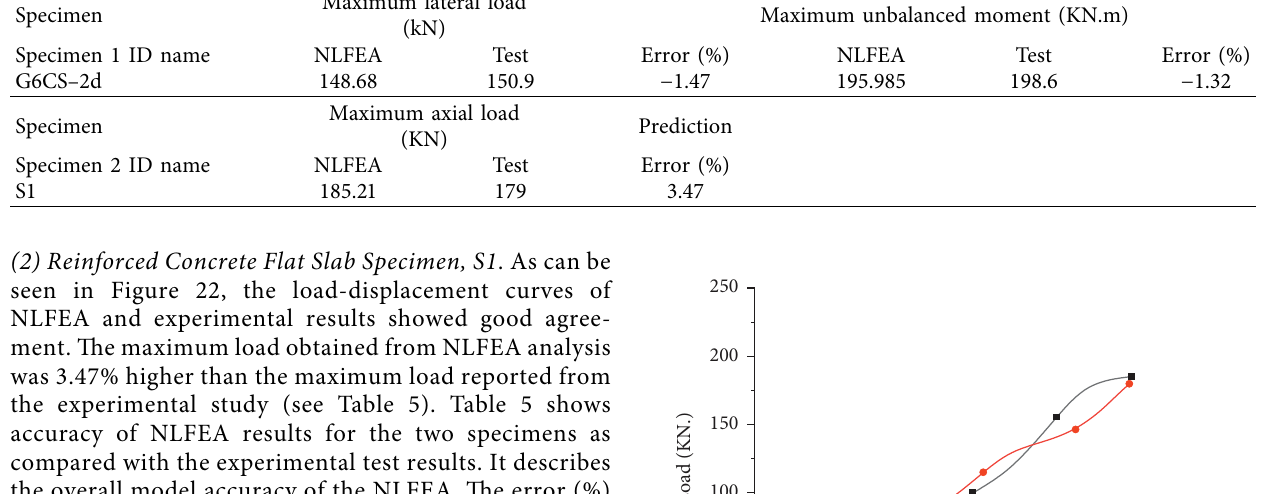
Table 5: Maximum unbalanced moment and maximum load comparisons of NLFEA prediction with the test results of the two specimens. Specimen